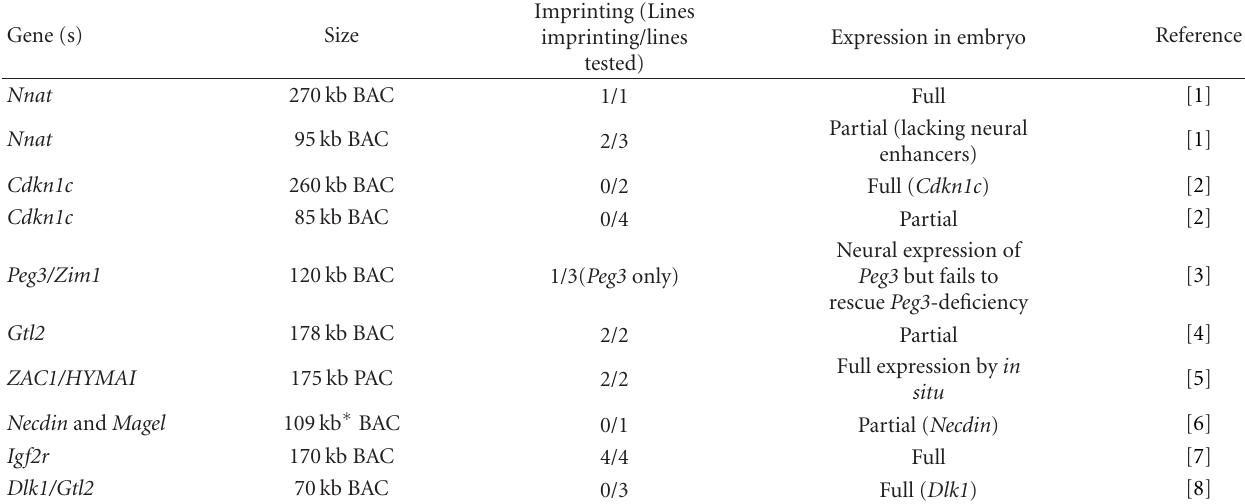
Table 1: Summary of BAC transgene models used to test for autonomous imprinting.